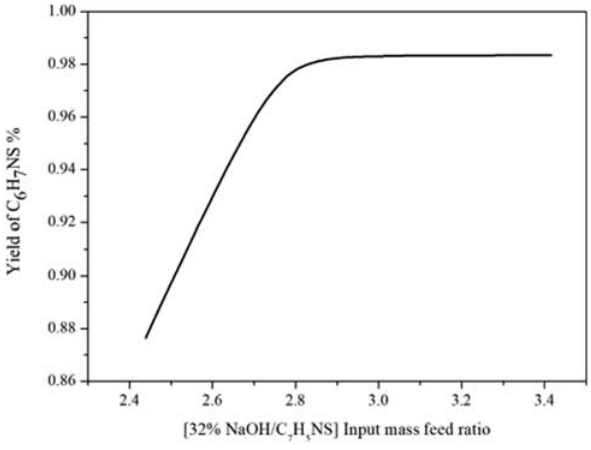
Figure 5: Relationship between NaOH/C 7 H 5 NS feed ratio and C 6 H 7 NS yield.